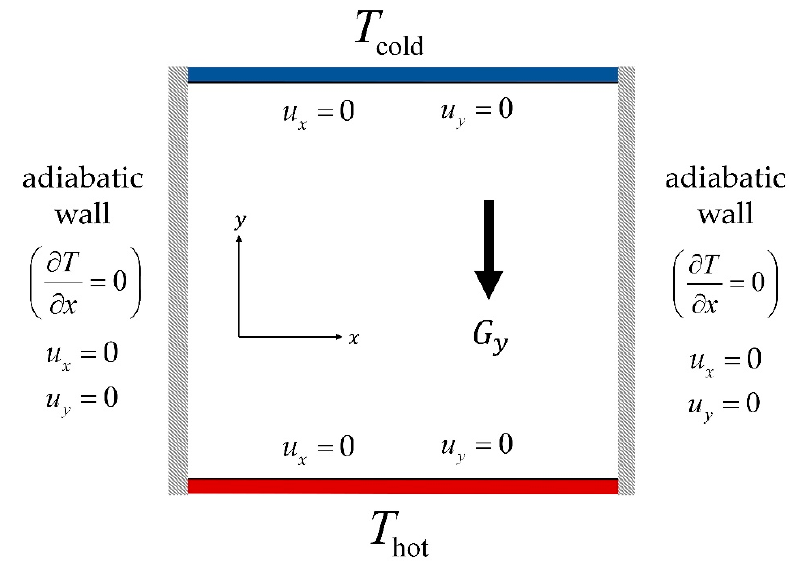
Figure 6. Domain configuration for two-dimensional Rayleigh-Bènard convection with aspect ratio one.